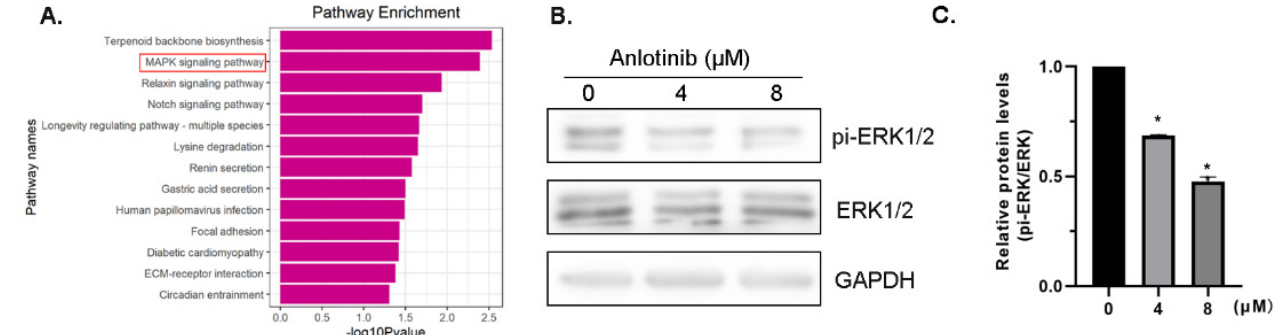
Figure 4. Involvement of the MAPK/ERK signaling pathway in mediating the anti-tumor effect of anlotinib. ( A ) Enrichment analysis of differentially expressed genes. ( B , C ) Western blot analysis of ERK1/2 activity in A2780 CIS cells treated with anlotinib ( B ) and the relative quantification of phosphorylated ERK1/2 and total ERK1/2 ( C ). All experiments were performed in at least three biological replicates, and each biological replicate contained three technical replicates. Student’s t - test was used to compare values between control and different treatment groups. * p < 0.05 indicates a significant difference when compared to the control.